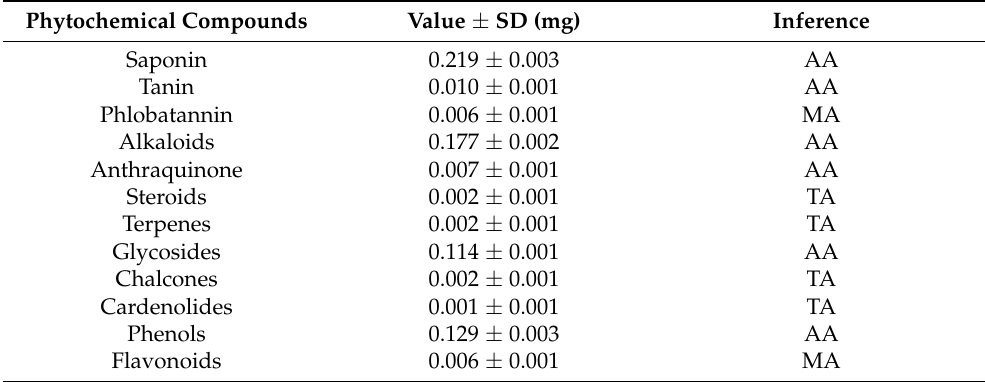
Table 4. Phytochemical analysis of baobab fruit